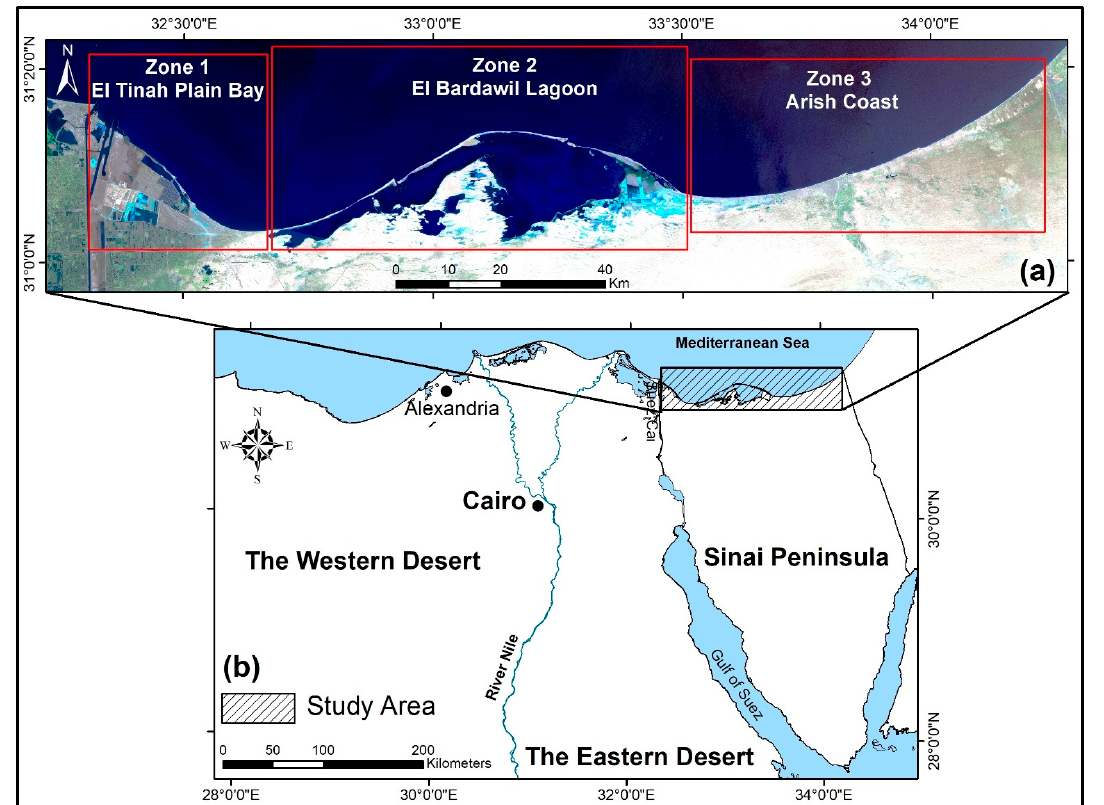
Figure 1. Study area ( a ) overall; and ( b ) within Egypt.